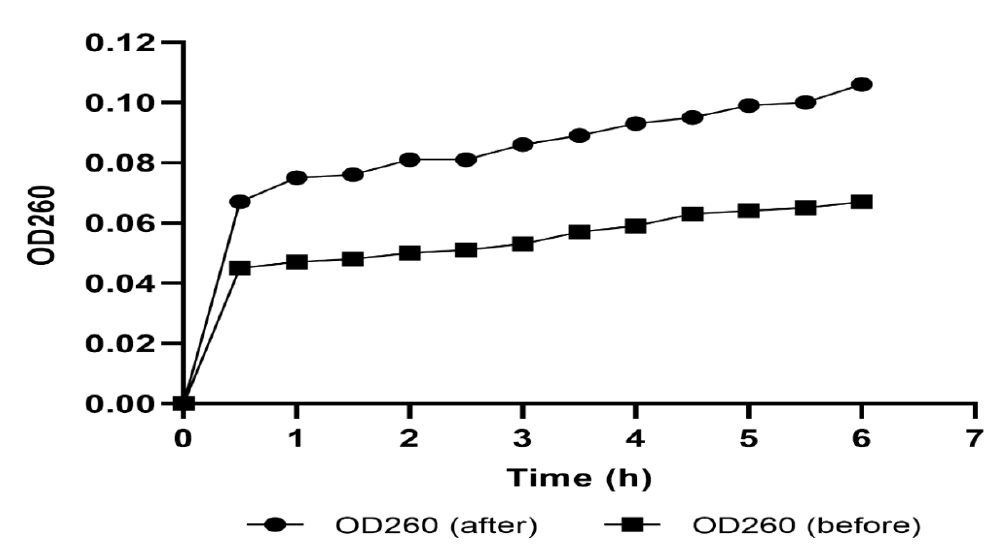
Figure 2. An illustrative example for the significant decrease in the membrane integrity in A. baumannii isolate (A1) after treatment with SAME.